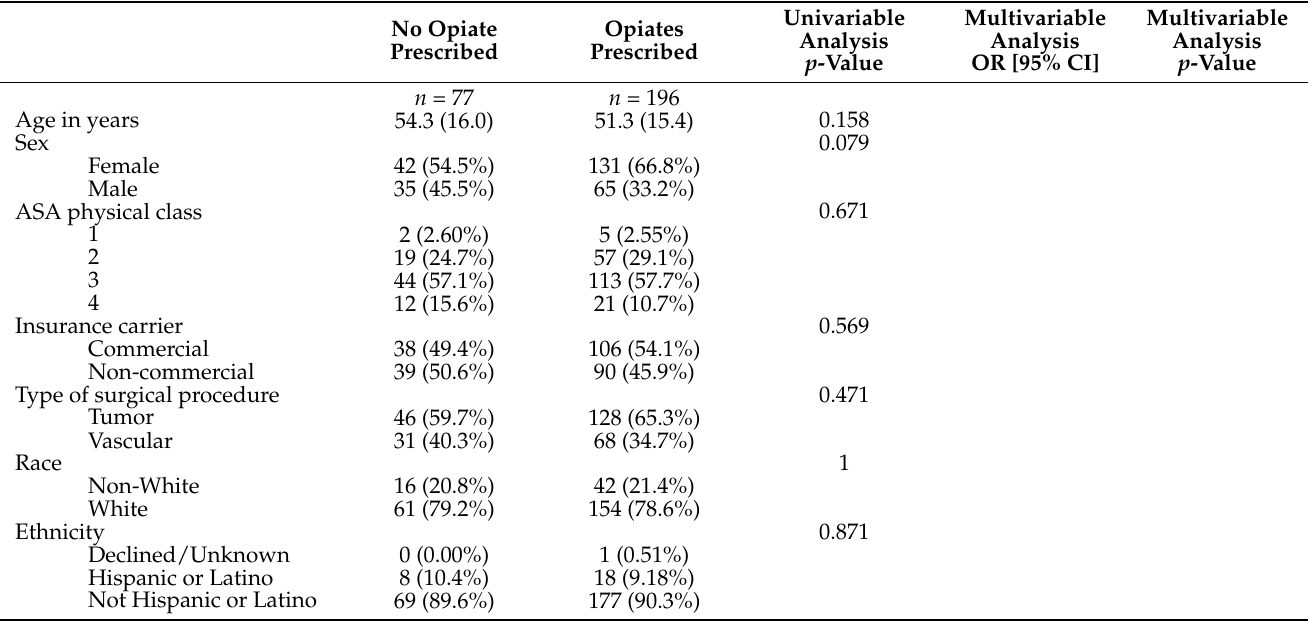
Table 2. Factors Associated with Prescription of Opioids at the time of Hospital Discharge After Craniotomy for Tumor Resection/Vascular